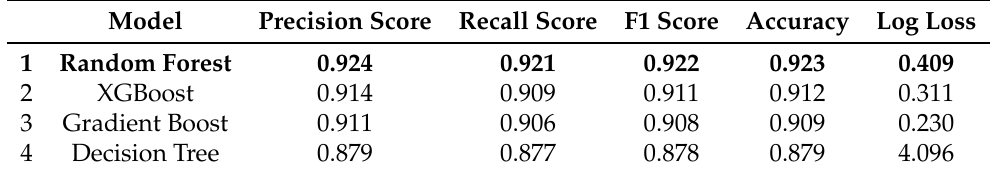
Table 4. Performance of models after pruning.